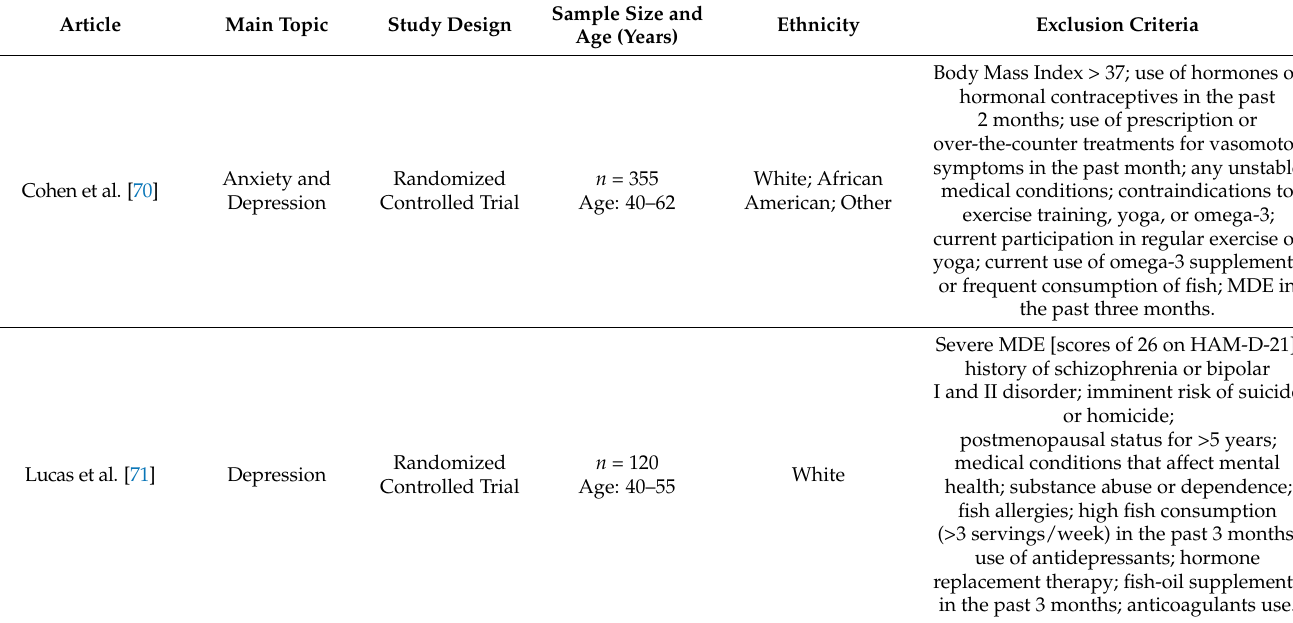
Table 4. Data extracted from human studies: topic, study design, age, sample and exclusion